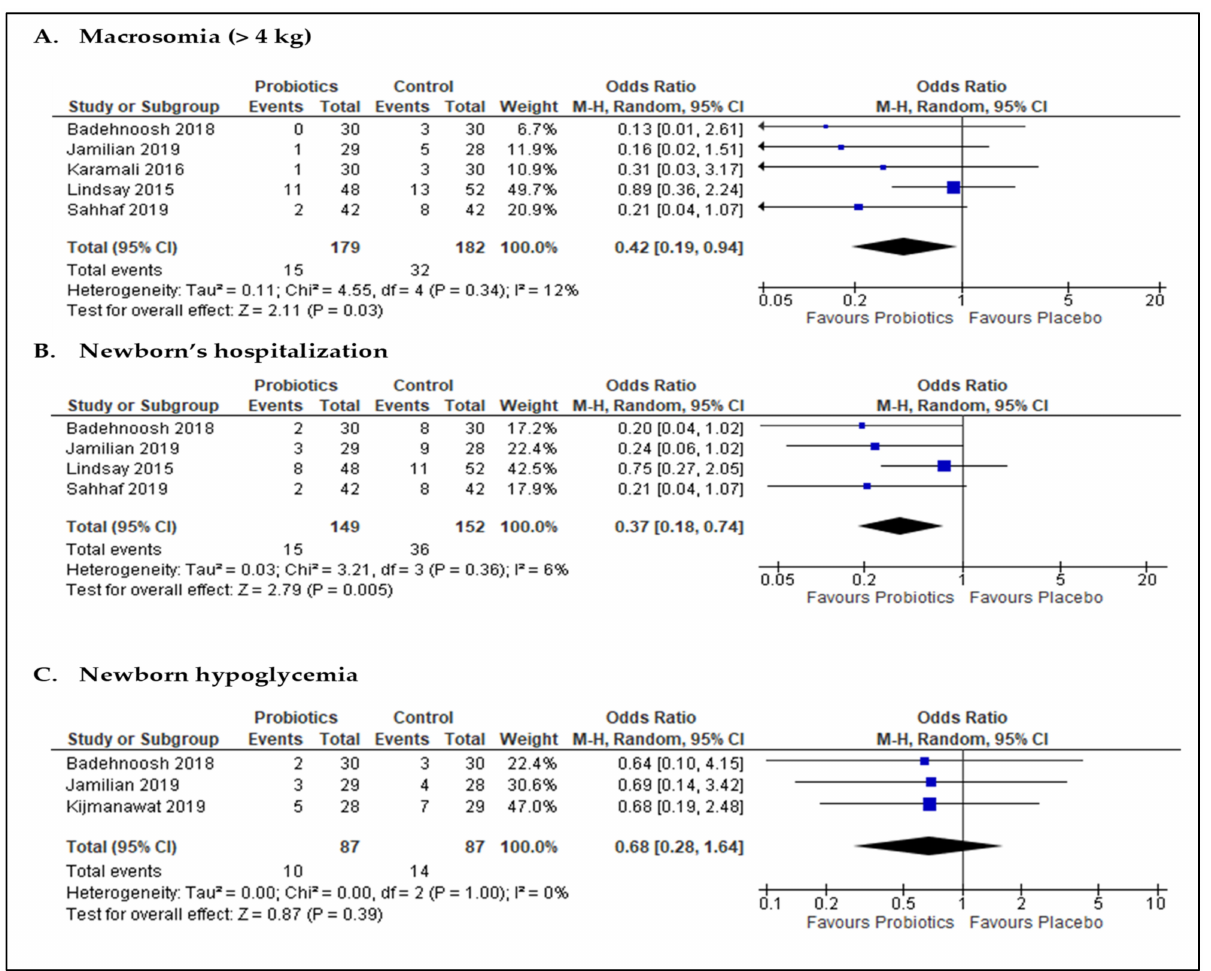
Figure 6. Forest plots for the meta-analysis of neonatal outcomes: ( A ) macrosomia, ( B ) newborn’s hospitalization, and ( C ) newborn